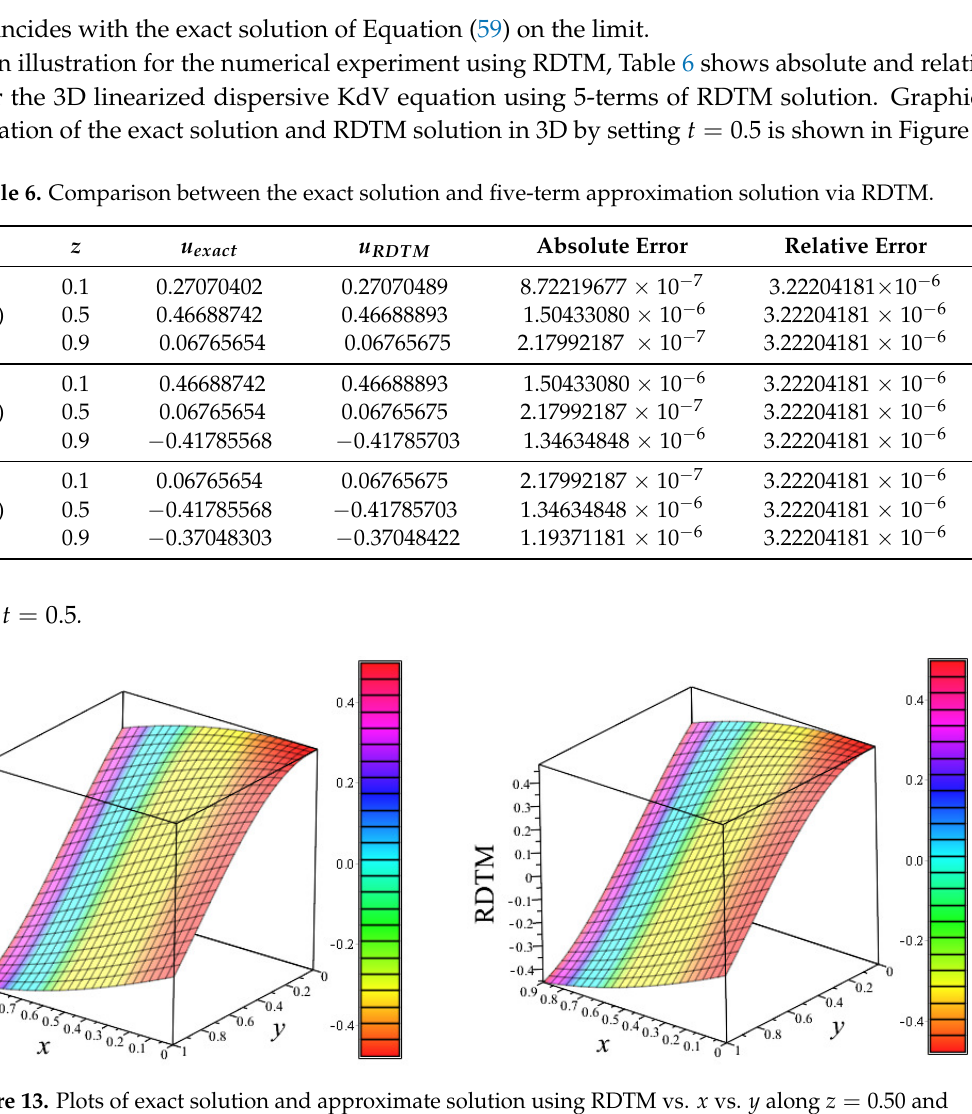
Figure 13. Plots of exact solution and approximate solution using RDTM vs. x vs. y along z = 0.50 and at t =